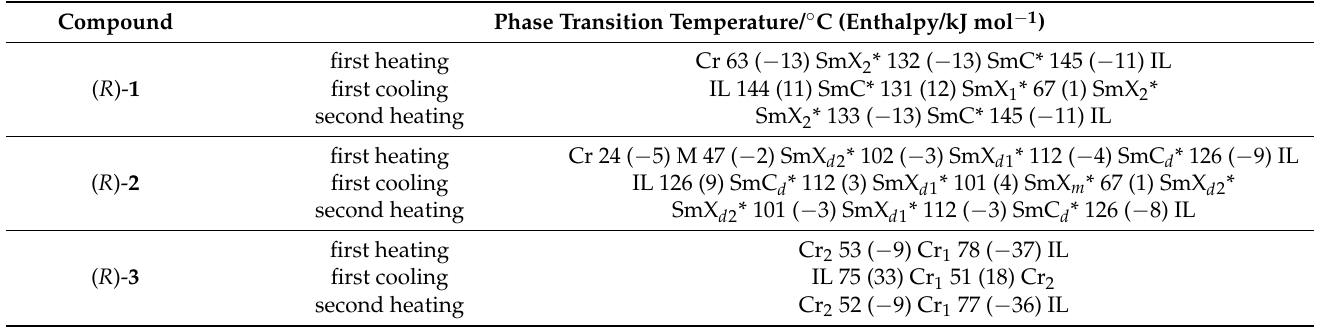
Table 1. Phase transition behavior of ( R )- 1 , ( R )- 2 , and ( R )- 3